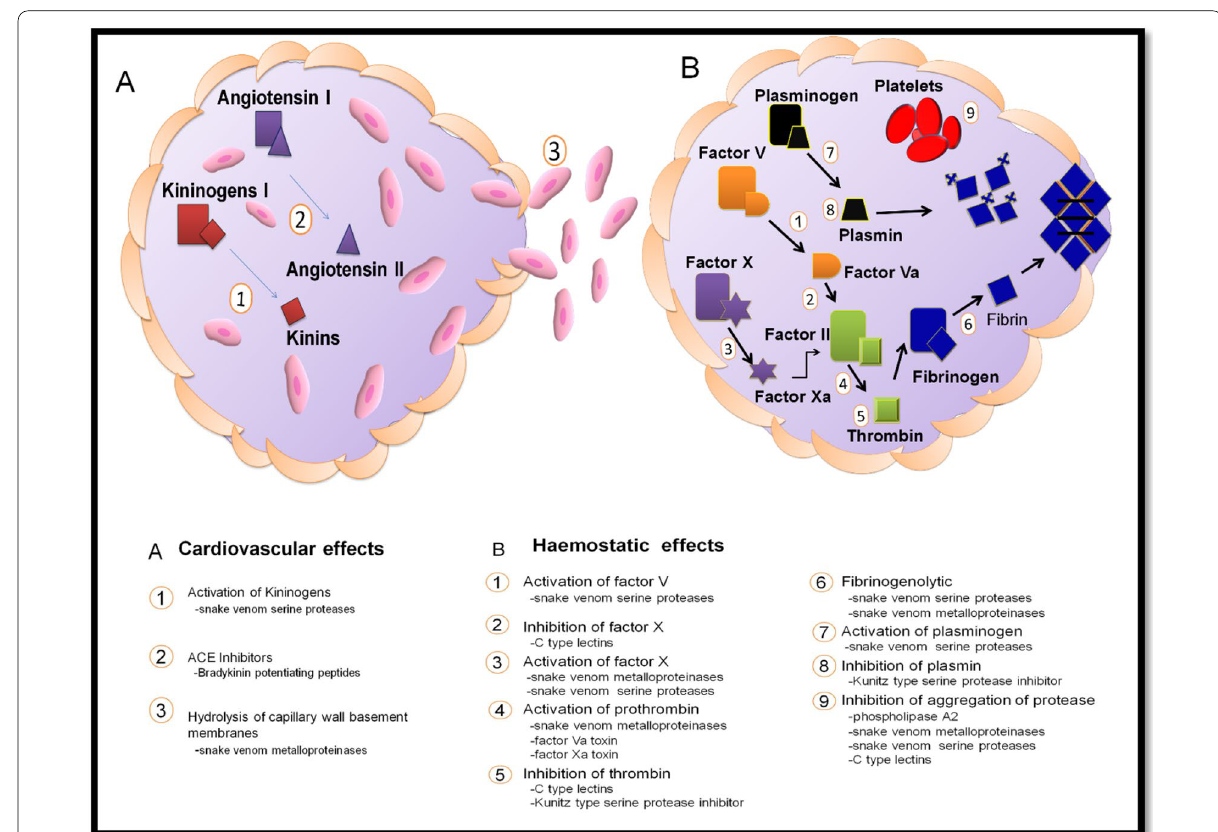
Fig. 1 Mechanism of action of different venom peptides acting on cardiovascular and hemostatic